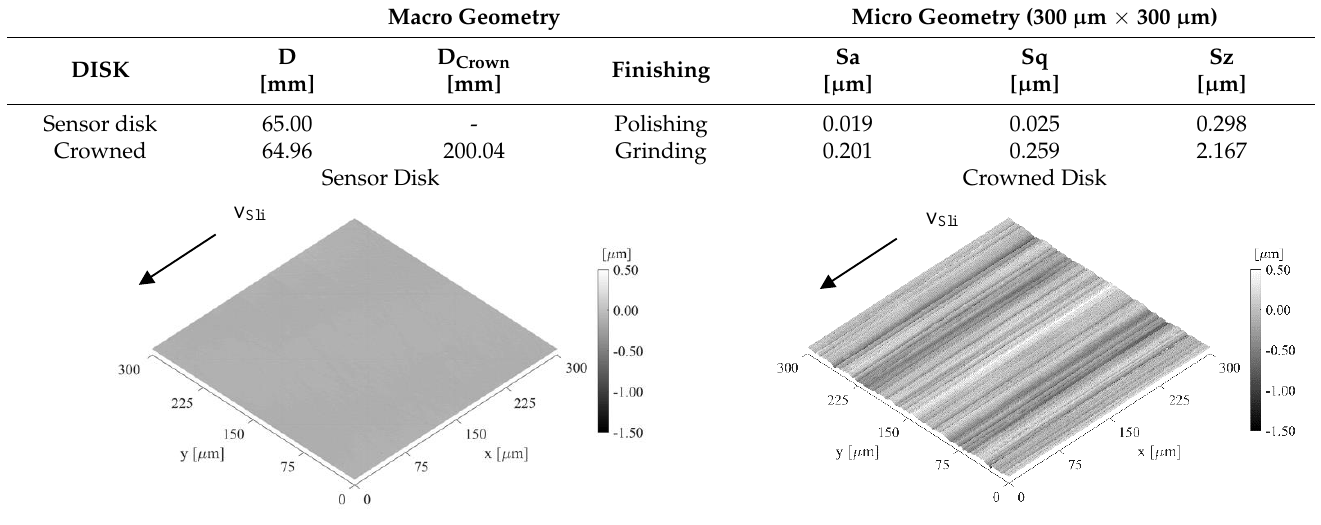
Table 2. Elastic-plastic properties of the